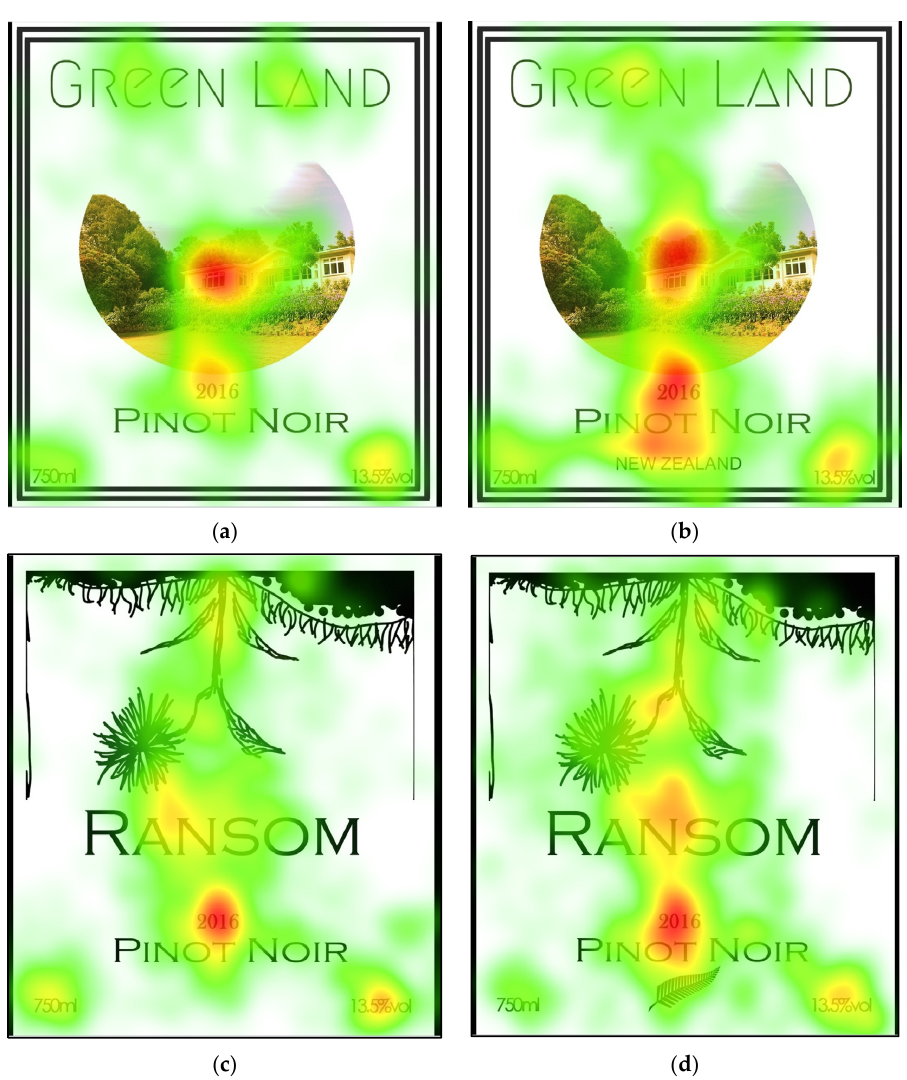
Figure 3. A heat map representation of the labels used for Study 1. Four labels were tested in this study: ( a , b ) had the same design, but one included a piece of COO information, in the textual form, “New Zealand” ( b ), whereas the other did not ( a ). Similarly, ( c , d ) had a matching design (different from ( a , b )), but one included COO information in the form of a symbol, i.e., fern—a well-known logo in New Zealand ( d ), whereas the other did not ( c ).